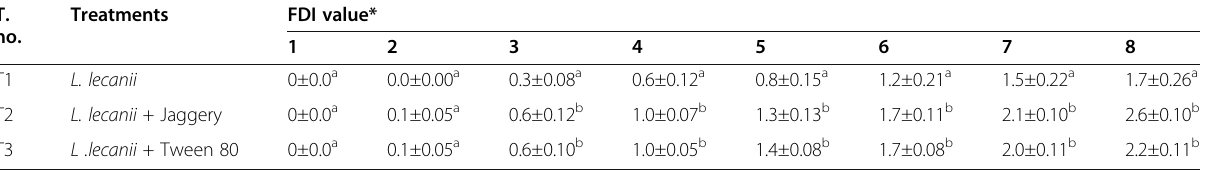
Table 3 Comparison of fungal development index (FDI) of conidial treatments Lecanicillium lecanii infecting the 2nd instar nymphs of Scirtothrips bispinosus T.